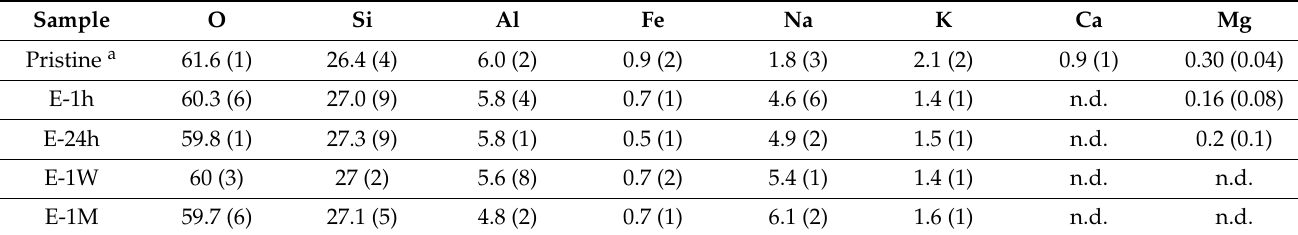
Table 4. Surface quantitative composition (at%) of erionite samples incubated in the simplified Gamble’s solution. Average values and standard deviation (in parentheses) over three measurements are reported. a Reference data of Pacella et al. [35]. “n.d. means not detected”.